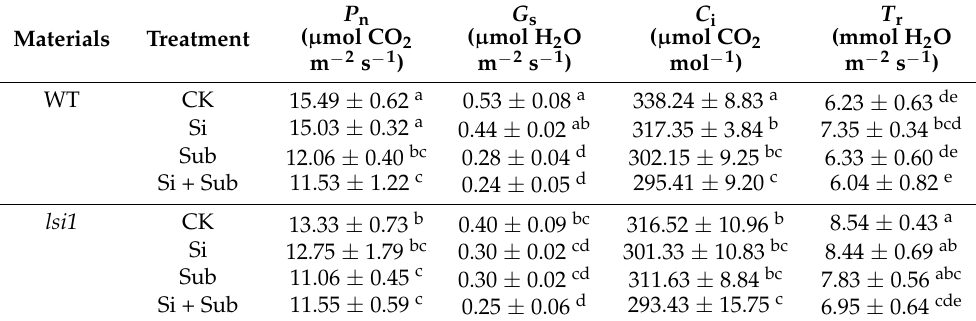
Table 2. Effects of Si application on photosynthesis of rice leaves under submergence stress.